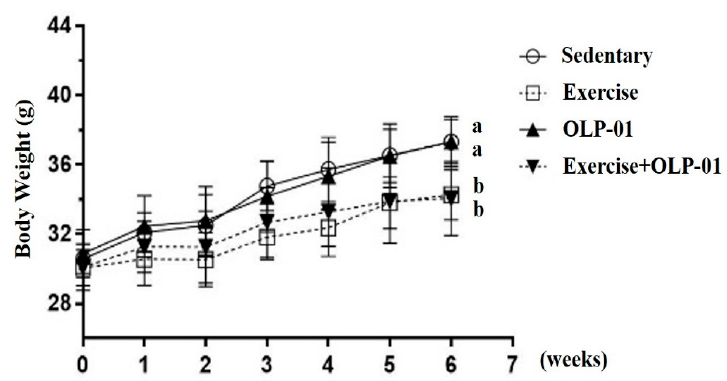
Figure 2. Effects of six weeks of exercise and probiotic interventions on the growth curve. Data are expressed as the mean ± SD per group. Bars with different letters (a, b) were significantly different at p < 0.05.